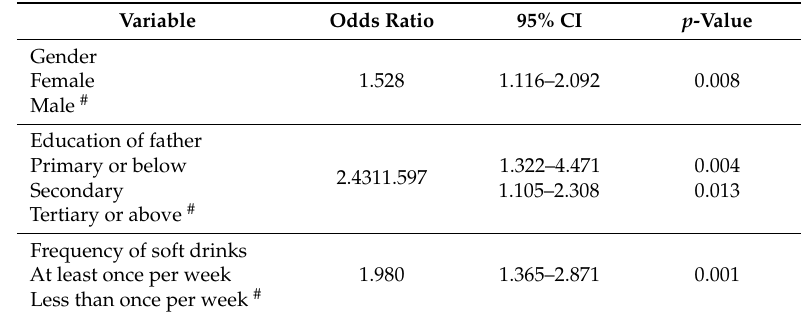
Table 3. Results of logistic regression of the association between caries prevalence and explanatory variables among children in Jakarta ( n = 696).